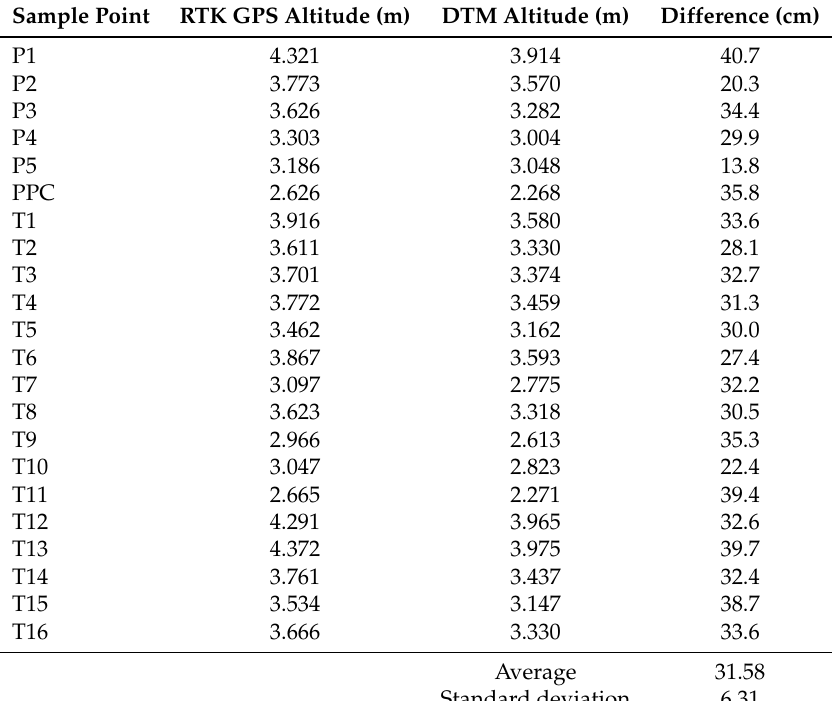
Table A1. Elevations of the 22 samples points measured using RTK GPS to assess and correct DTM